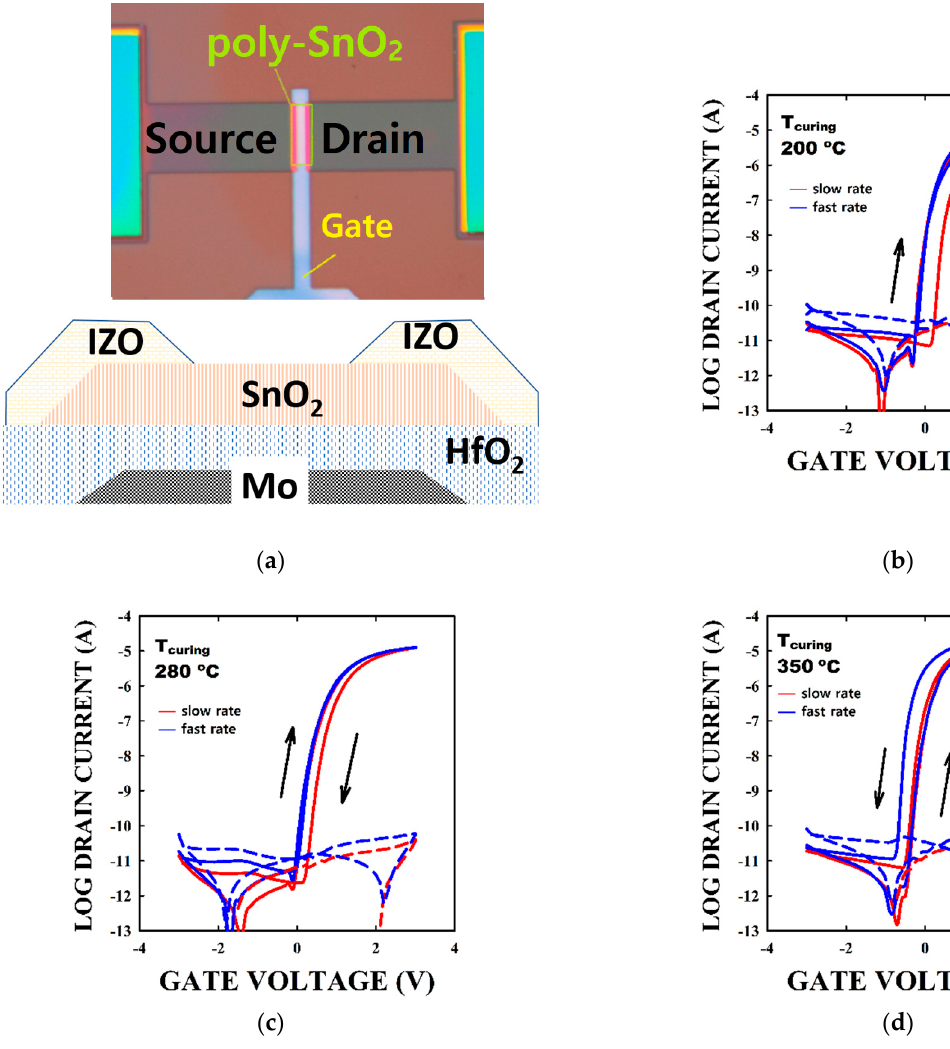
Figure 3. TFT structure and initial IV characteristics. ( a ) the TFT micrograph ( top ) and the TFT structure ( bottom ). The transfer of the poly-SnO 2 TFTs using a SnO 2 layer cured at a T curing of ( b ) 200, ( c ) 280, and ( d ) 350 °C, respectively. The solid (dash) line refers to I DS (I GS ) measured at V DS = 0.1 V. The arrows indicate the direction of the hysteresis.